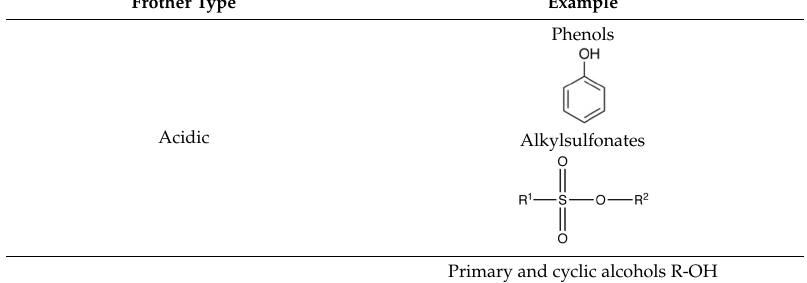
Table 5. Classification of frothers according to their pH-sensitivity [15,23].